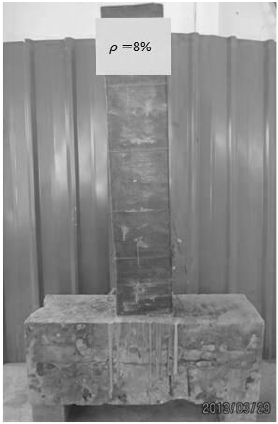
Figure 10. Z4 ( ρ = 8%, two layers).